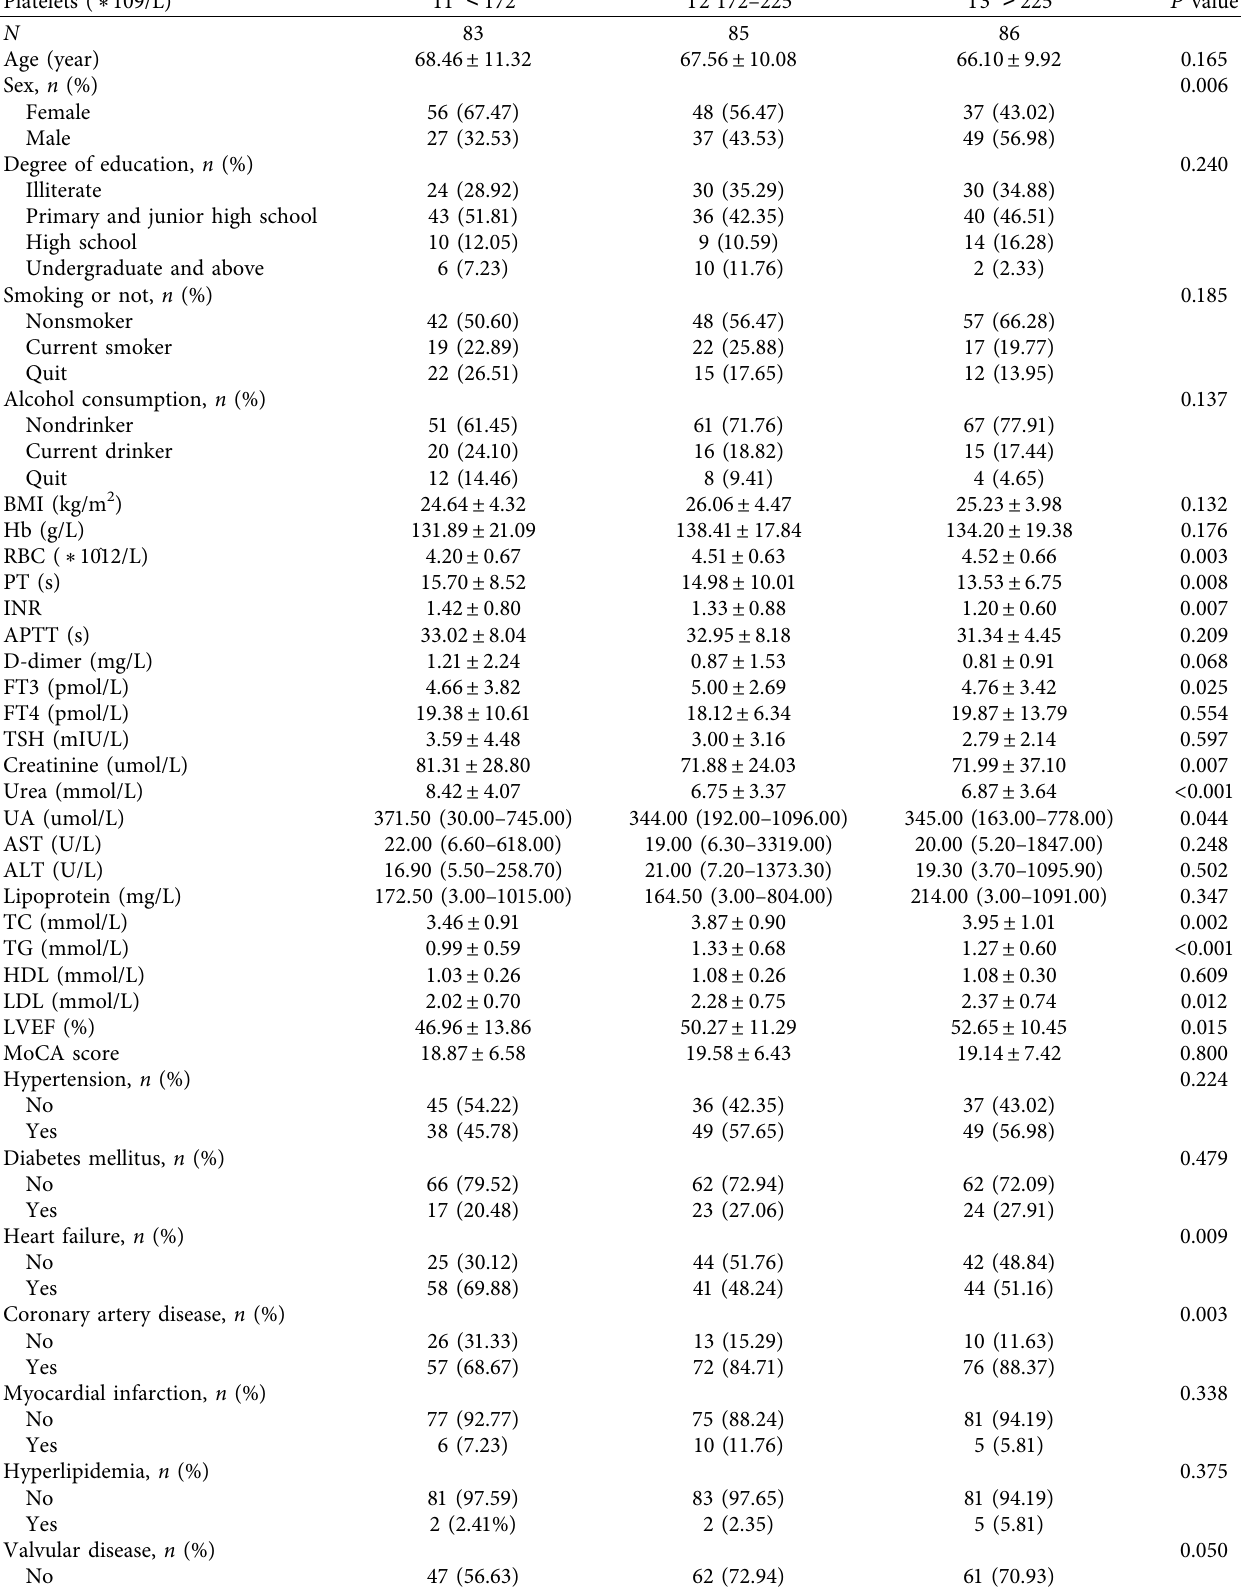
Table 1: Baseline characteristics of